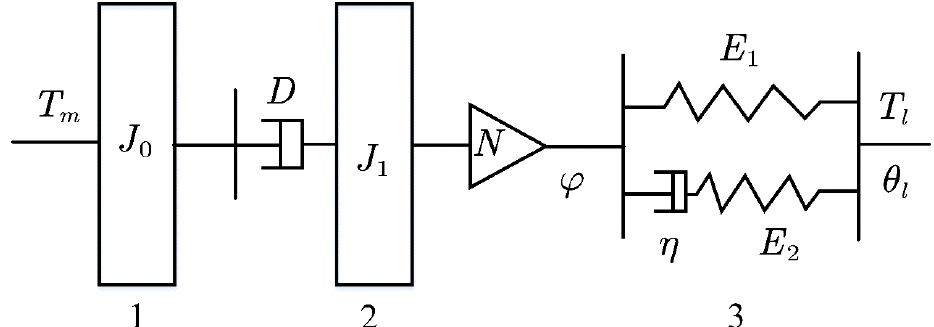
Figure 2. The simplified schematic diagram of the dynamic model of the SVA: (1) motor, (2) harmonic drive, (3) rubber. T m and T l are the motor torque and load torque respectively, J 0 includes the inertia of the motor rotor and harmonic drive, damping D includes the damping of the harmonic drive and other rotating pairs of the system which is usually a nonlinear function of 𝜑(cid:4662) . J 1 includes the inertia of harmonic drive. N is the reduction ratio. E 1 , E 2 , η are the rubber model parameters. 𝜑(cid:4663) , 𝜑(cid:4662) , 𝜑 are angular acceleration, angular velocity and angular position, respectively.